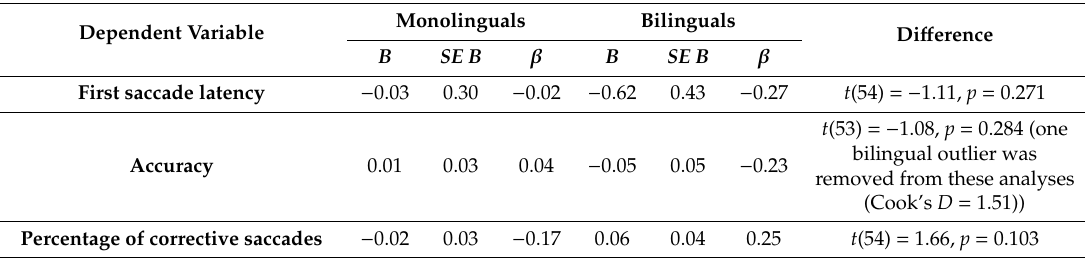
Table A2. Regression coe ffi cients and t-statistics of the relationship between rumination and the dependent variables (prosaccade trial performance).